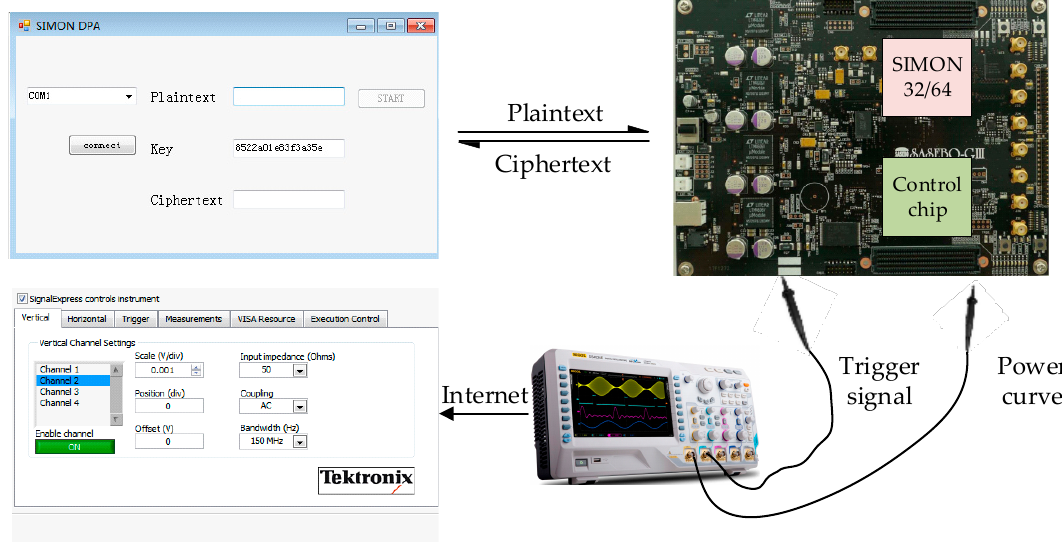
Figure 3. The structure of DPA attack platform.